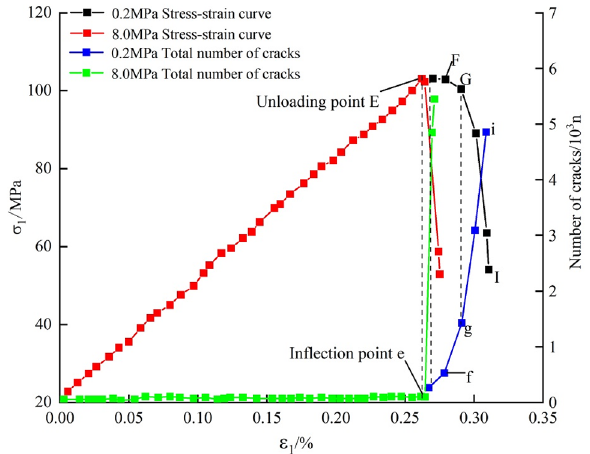
Figure 7. The stress-crack number-strain curves at different unloading rates of the confining pressure.